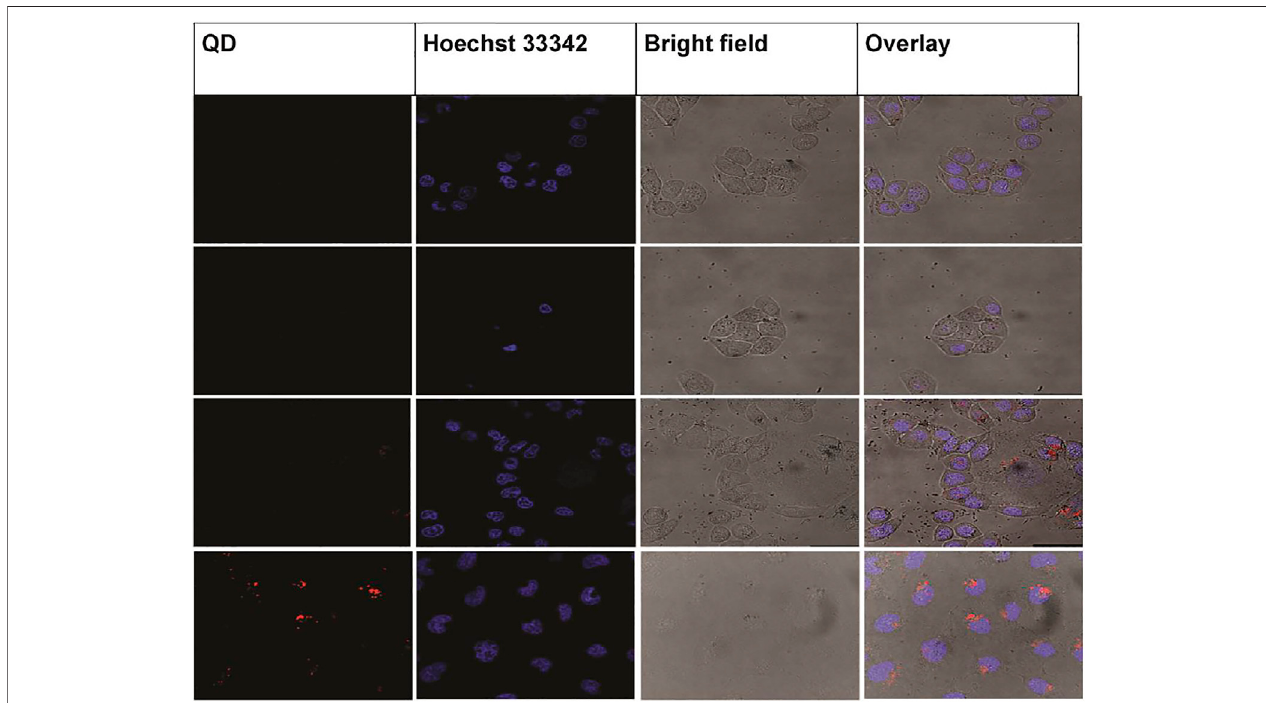
FIGURE3| ConfocalphotographsofvariouscellstreatedwithCdSe/ZnS@L-Cys-MPPDA(200 μ g/ml)for6 hat37 ° C.ReproducedfromZhangetal.(2020)under creative commons CC BY license. Copyright © 2020 Zhang et al.